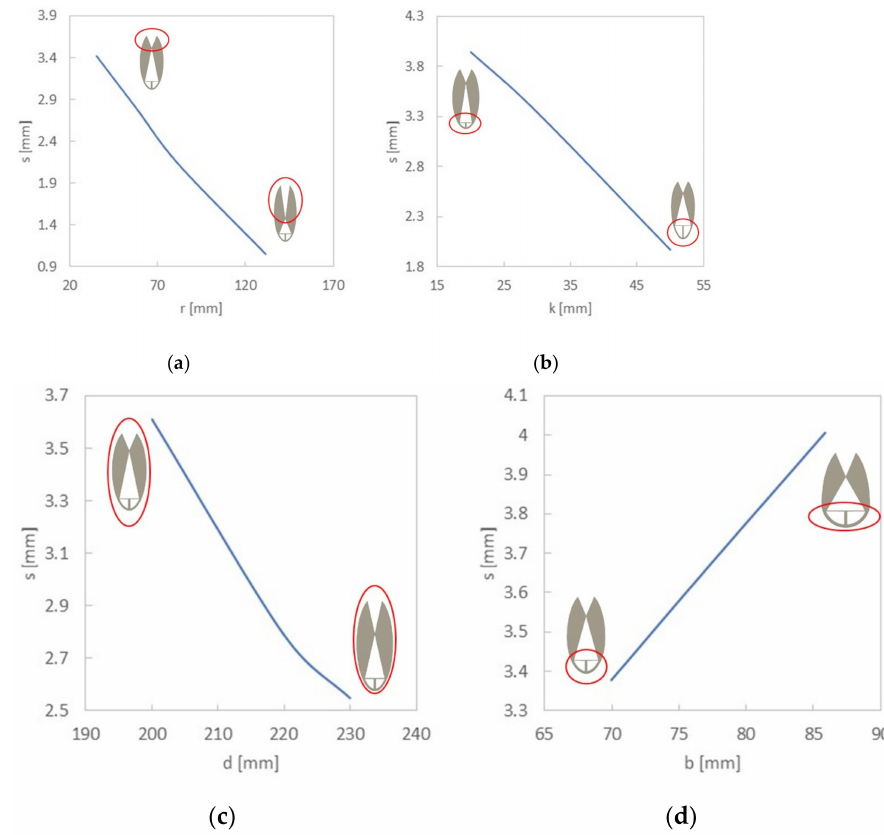
Figure 6. Numerical calculations results. The individual graphs present the dependence of the deflection of the replaceable measuring head on the length of the lower edge ( a ), length of the element pressing against the sample ( b ), sample length ( c ) and length of the replaceable measuring head ( d